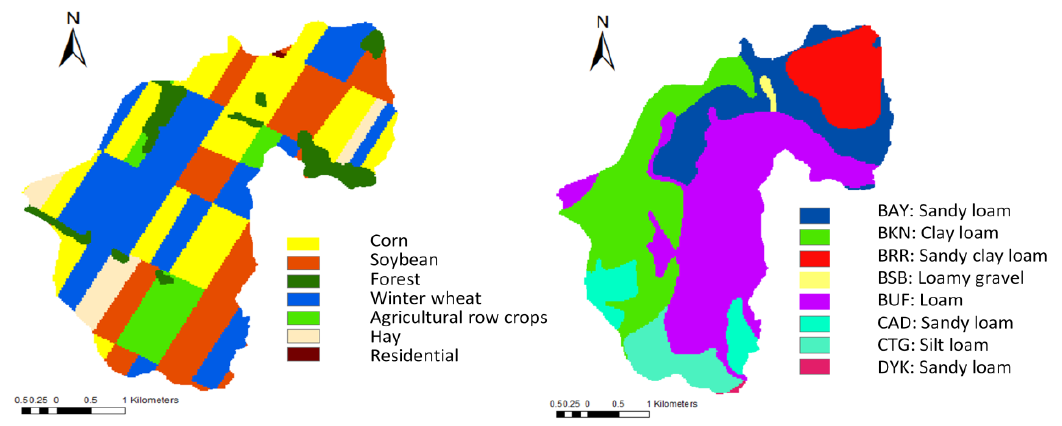
Figure 2. Land use and soil type maps.